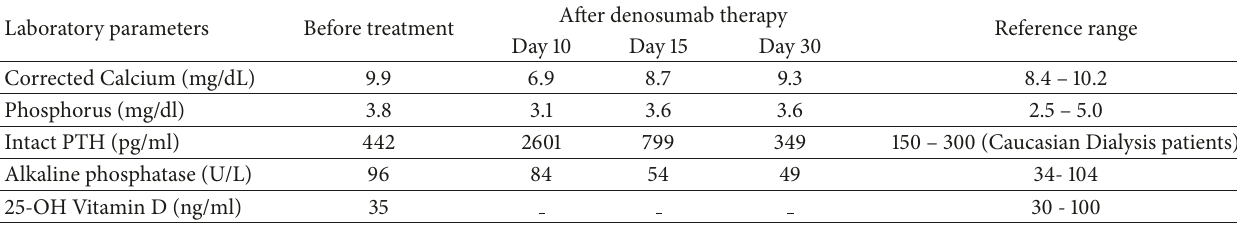
Table 1: Laboratory data at baseline and after denosumab